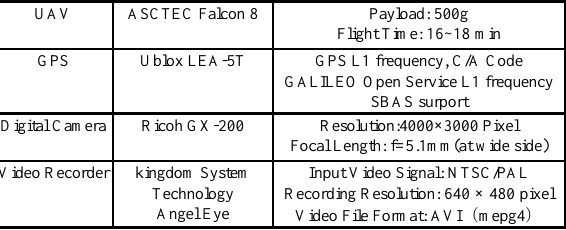
Table1. Details of Integrated Devices